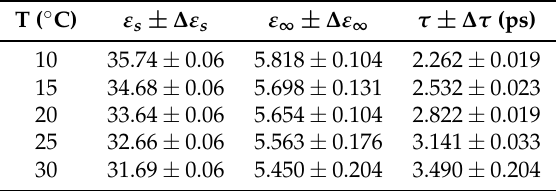
Table A1. ε s , ε ∞ and τ values and uncertainty for methanol